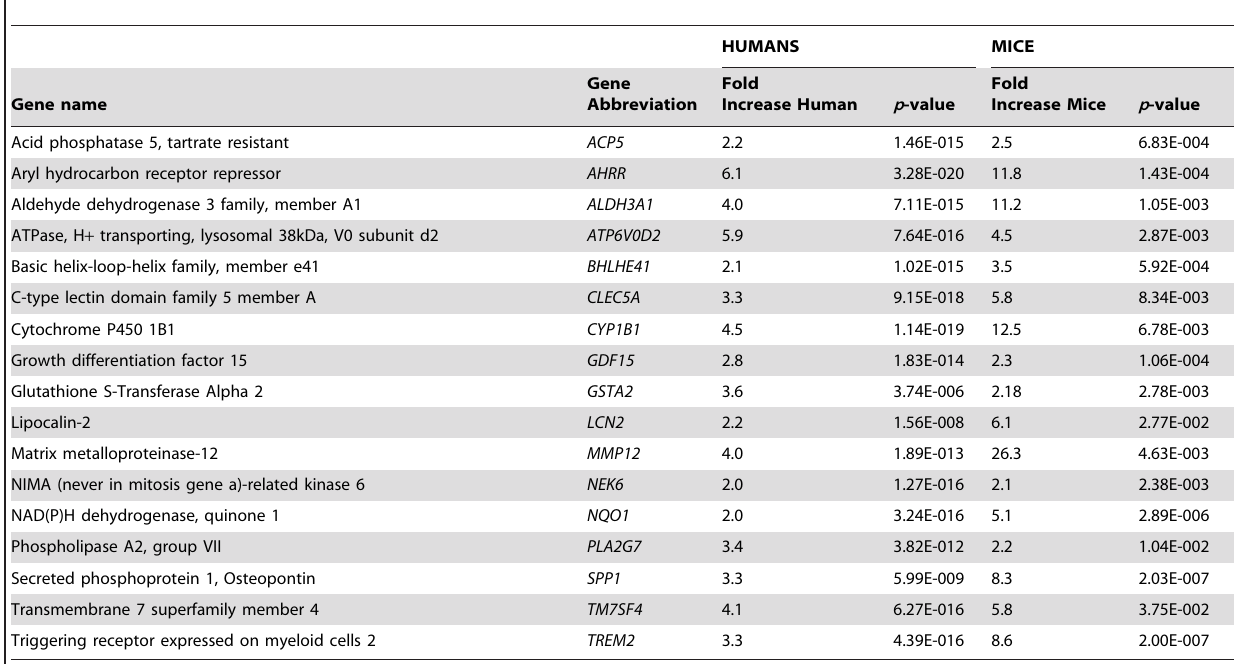
Table 2. Genes significantly upregulated by cigarette smoke exposure in the human and mouse lungs.